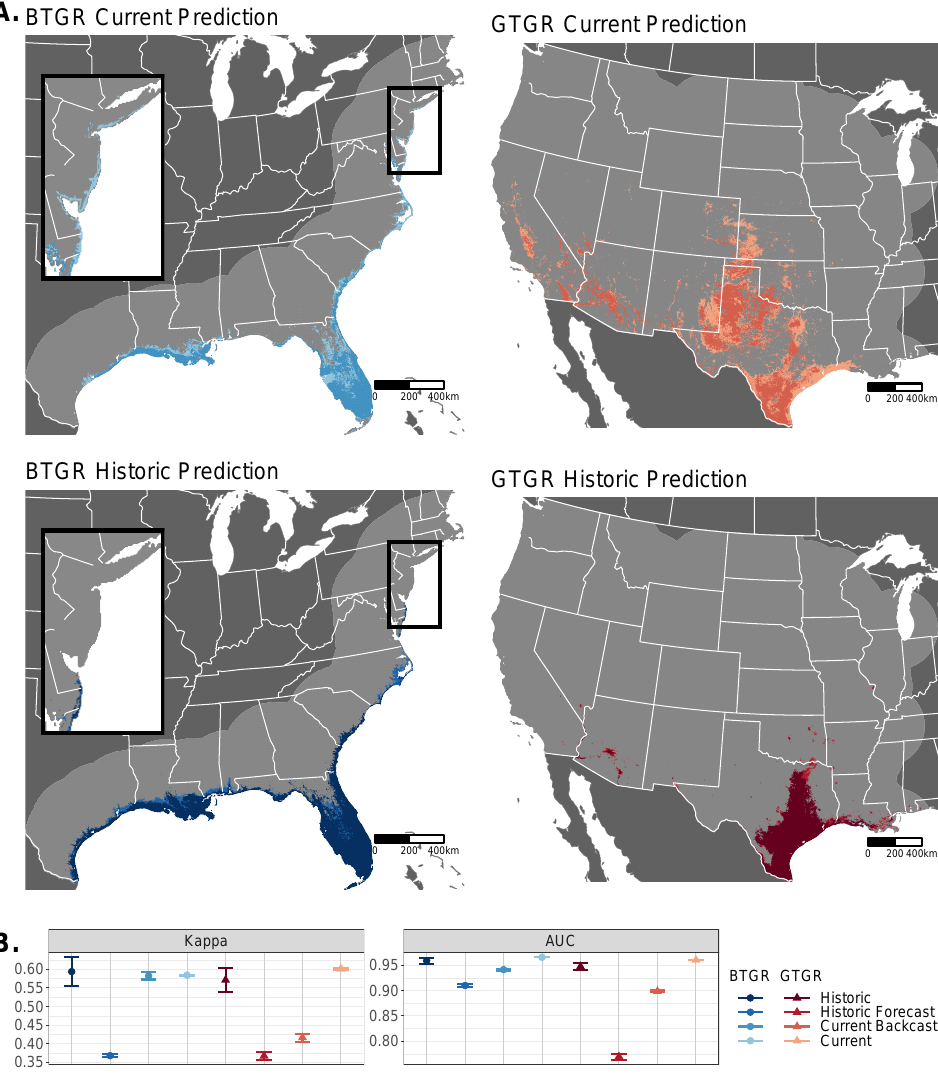
Figure 3 – Predicted suitability maps and discrimination ability of SDMs. (A) Maps display areas where predicted suitability is greater than the maximum-sensitivity-specificity thresholds for each model (great-tailed grackle (GTGR) current: 0.4440, boat-tailed grackle (BTGR) current: 0.4780, great-tailed grackle (GTGR) historic: 0.4635, boat-tailed grackle (BTGR) historic: 0.3935). Darker shaded regions are predictions made using the historic environment (historic and current back- cast) and lighter regions are predictions made using the current environment (historic forecast and current). The northern edge of the boat-tailed grackle range is expanded in a map insert for clarity. Overall, the areas of lighter color indicate changes in habitat availability from 1979-2019, as predicted by each model. (B) The ability of each model to predict the presence or absence of boat-tailed grackles (blues) or great-tailed grackles (reds) using Cohen’s kappa (agreement between presence or absence classification for model and true presence or absence) and AUC (area under the sensitivity-specificity curve). The models were tested using either test data excluded from the training data set (historic and current predictions) or test data from the opposing temporal period (backcast and forecast predictions). Error bars signify one standard deviation in the values across 10 replicates. The high values of the boat-tailed grackle historic, current backcast, and current, and the great-tailed grackle historic and current models indicate that these models are accurate, while the lower values of the boat-tailed grackle historic forecast and the great-tailed grackle historic forecast and current backcast models indicate that the boat-tailed grackle historic and the great- tailed grackle historic and current models have poor